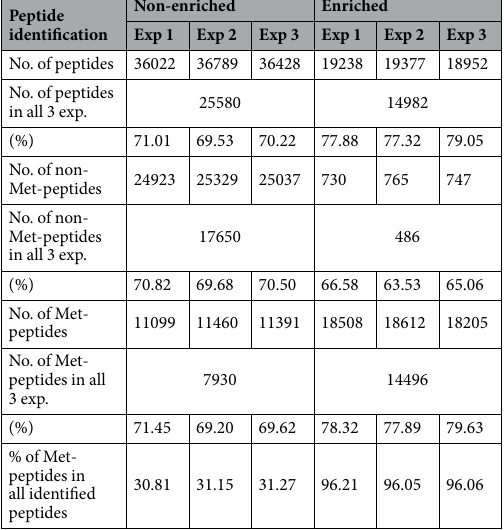
Table 1. Efficiency and reproducibility of the iodoacetyl-PEG2-biotin-based protocol to enrich Met-peptides derived from A431 cell lysates. A431 cell lysates were digested by trypsin, and the digests were equally divided into three parts. For each part, the tryptic digests (200 μ g protein) were subjected to Met-peptide enrichment using the iodoacetyl-PEG2-biotin-based protocol. After enrichment, one-fourth of the enriched product (equivalent to 50 μ g protein of the original lysates) was analyzed by LC-MS/MS for peptide identification. The tryptic digests (10 μ g protein) were directly analyzed by LC-MS/MS without prior enrichment for comparison purpose. “% of Met‐peptides” represents the percentage of Met‐peptides among the total identified